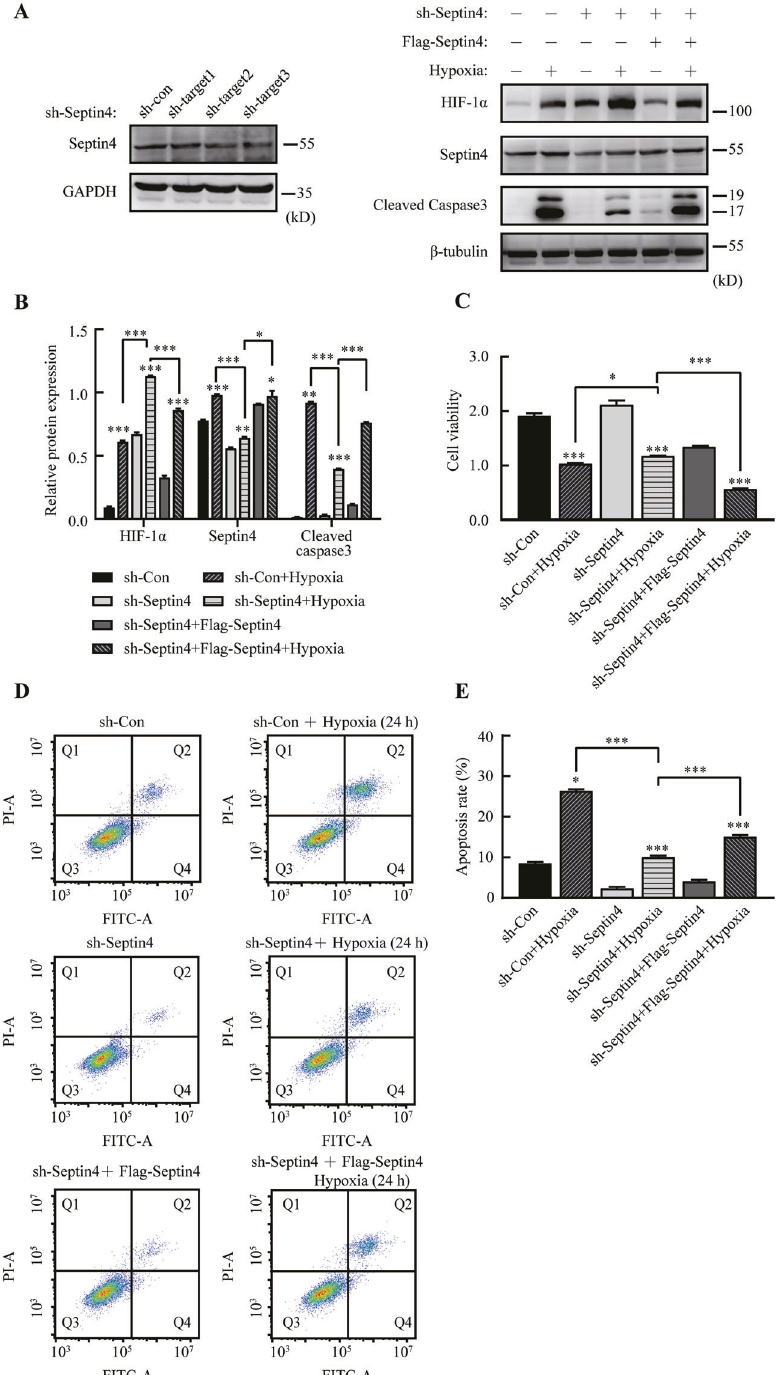
Fig. 2 Septin4 aggravates hypoxia-induced cardiomyocytes injury by down-regulating HIF-1 α levels. A , B Western blot analysis of the role of Septin4 in regulating the expression levels of HIF-1 α in sh-Septin4 H9c2 cells transfected with vector empty or Flag-Septin4 under hypoxia for 24 h. C Cell viability assay of sh-Septin4 H9c2 cells ’ viability after transfected with vector empty or Flag-Septin4 under hypoxia for 24 h. D , E Flow cytometry analysis of sh-Septin4 H9c2 cells ’ apoptosis rate after transfected with vector empty or Flag-Septin4 under hypoxia for 24 h. All data are presented as mean ± SD of three repeated experiments; ***<0.001, **<0.01, *<0.05. One-way ANOVA with Tukey ’ s multiple comparisons test ( B , C , and E